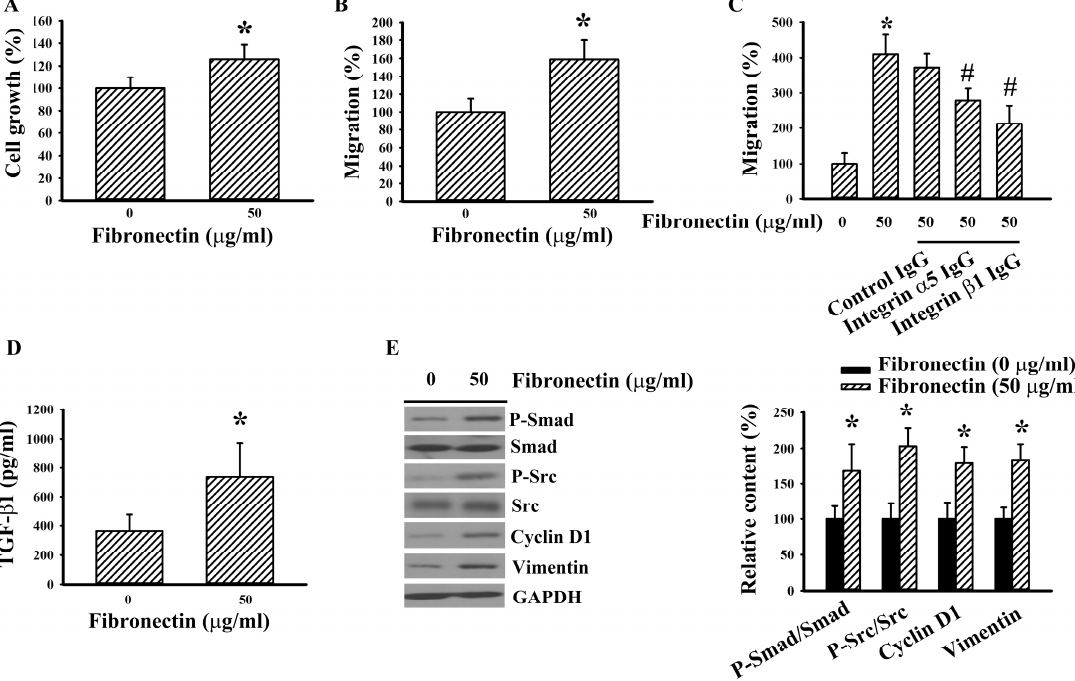
Figure 6. Fibronectin increased cell growth and migration in Caki-1 cells. ( A ) Caki-1 cells were seeded onto fibronectin (0 and 50 µ g / mL)-coated 96-well plates. Twenty-four hours later, cell growth was measured by MTS reduction assay. ( B ) Caki-1 cells were seeded onto fibronectin (0 and 50 µ g / mL)-coated Transwell inserts and subjected to Transwell migration assay for 24 h. The lower chambers were filled with DMEM containing 10% FBS. ( C ) Caki-1 cells were first incubated with indicated IgG (5 µ g / mL) for 30 min before seeding to the Transwell inserts for migration assay (24 h). The lower chambers were filled with DMEM containing fibronectin (0 or 50 µ g / mL). ( D ) Caki-1 cells were seeded onto fibronectin (0 and 50 µ g / mL)-coated 24-well plates. Twenty-four hours later, the supernatants were collected and subjected to ELISA for the measurement of TGF- β 1. ( E ) Caki-1 cells were seeded onto fibronectin (0 and 50 µ g / mL)-coated six-well plates for 5 h. Proteins were extracted and subjected to Western blot analysis with indicated antibodies. Representative blots are shown. Bar graphs show quantitative results among groups and the value in uncoated group was defined as 100% ( A – C , and E ). * p < 0.05 vs. uncoated control and # p < 0.05 vs. fibronectin (50 µ g / mL) untreated control, n = 3.